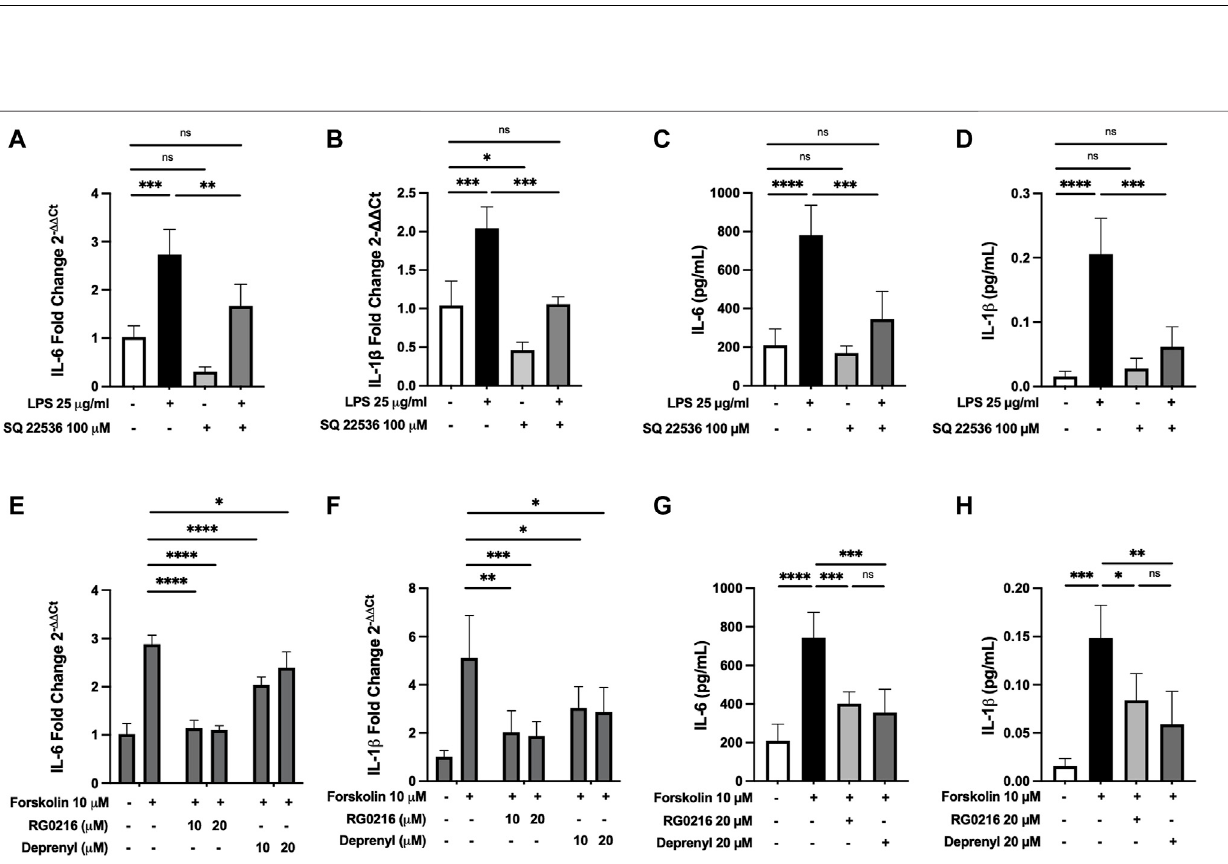
FIGURE 5 | RG0216 and deprenyl downregulate cAMP-mediated induction of IL-6 and IL-1 β gene and protein expression. Co-incubation of ± LPS-treated SiHa cell cultures with 100 µM SQ 22536 (an adenylyl cyclase inhibitor) effectively decreased LPS-induced pro-in fl ammatory gene expression for IL-6 (A) and IL-1 β (B) . The analysis was done using qRT-PCR ( n (cid:2) 4). SQ 22536 decreased LPS-induced IL-6 (C) and IL-1 β (D) protein expression as well ( n (cid:2) 5). Conversely, 10 µM forskolin (an adenylyl cyclase activator) alone signi fi cantly induced gene expression of IL-6 (E) and IL-1 β (F) and these forskolin-induced pro-in fl ammatory cytokines were signi fi cantlyreducedbybothRG0216anddeprenyl.TheanalysiswasdoneusingqRT-PCR( n (cid:2) 5).Forskolin-inducedIL-6 (G) andIL-1 β (H) proteinexpressionwasalso reduced by RG0216 and deprenyl ( n (cid:2) 5). Data presented as mean ± SD. ns, not signi fi cant, * p < 0.05, ** p < 0.01, *** p < 0.001 and **** p < 0.0001.